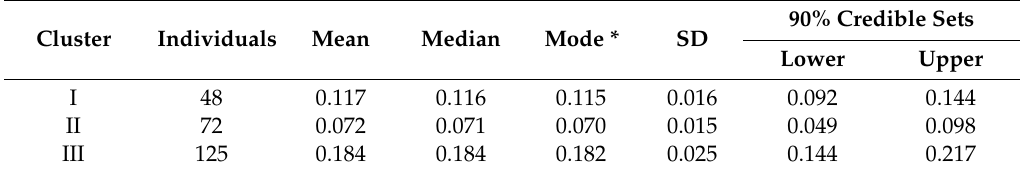
Table 3. Bayesian point estimation (mode, median, and mean) and 90% credible regions of Fst calculated in each group genetically differentiated of E. cladocalyx .